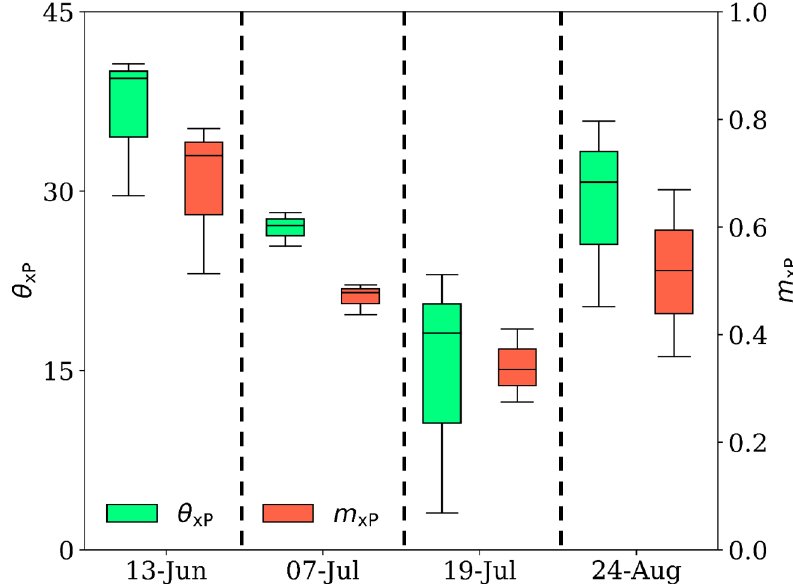
Figure 10. Temporal variation of θ xP and m xP over the wheat